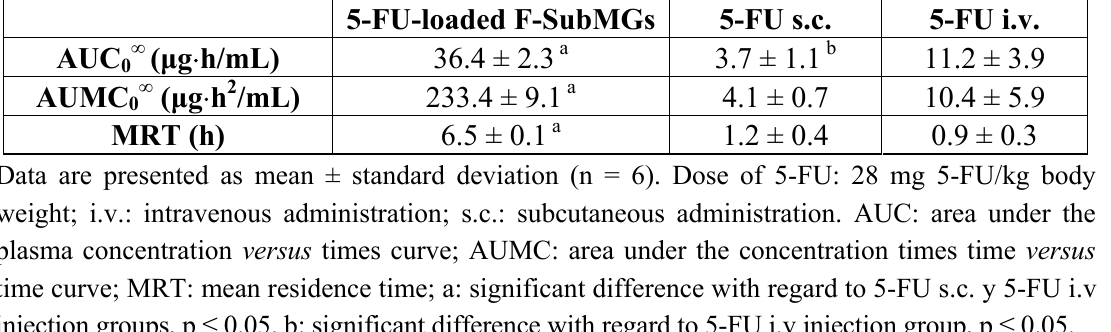
Table 1. Pharmacokinetic parameters of 5-Fluorouracil (5-FU) after subcutaneous injection of the 5-FU-loaded folate-conjugate submicrogels (F-SubMGs), subcutaneous (s.c.) injection of 5-FU, intravenous (i.v.) injection of 5-FU in